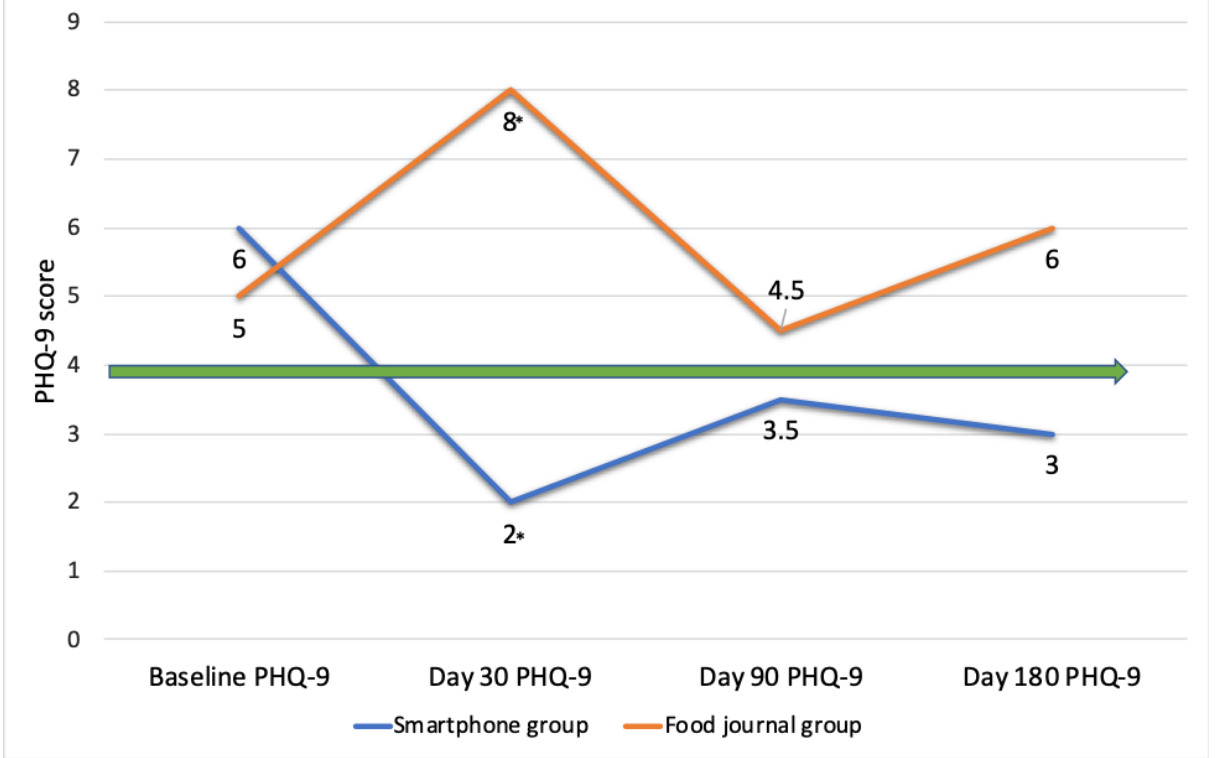
Figure 4. Depression by median Patient Health Questionnaire-9 (PHQ-9) score in the smartphone and food journal groups. Green arrow Indicates zero to minimal depression cutoff (PHQ-9 ≤ 4). *Statistically significant difference ( P